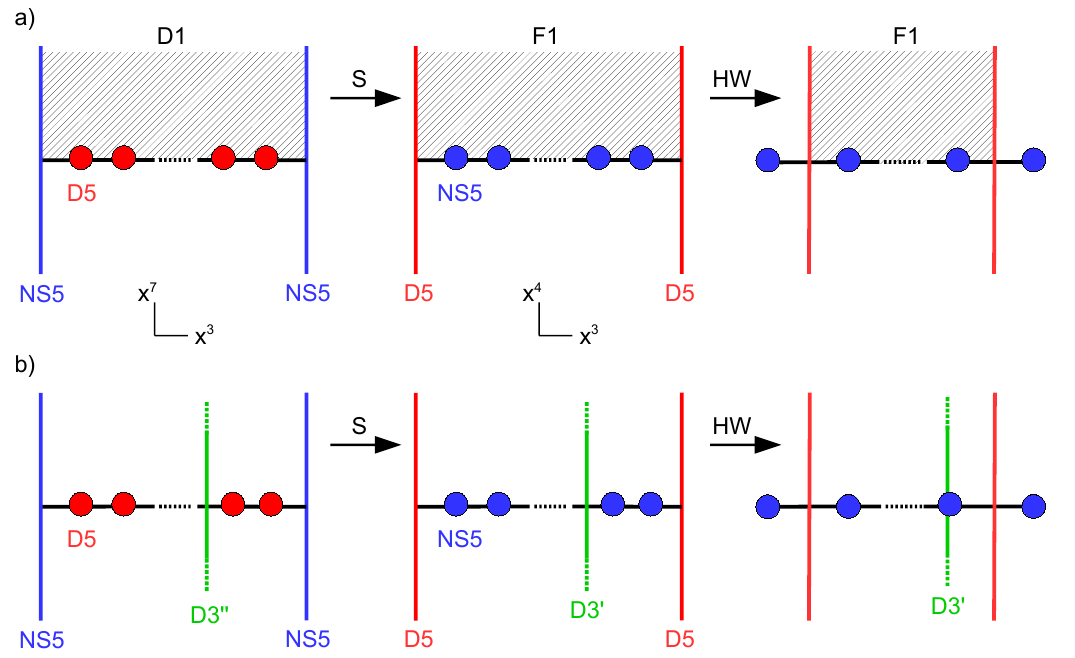
Figure 27 . a) From the brane setup realizing the SQED monopole operator u + to the setup realizing the insertion of the long meson W in T abel . b) From the brane setup realizing the SQED scalar operator ’ to the setup realizing the insertion of the meson Y (= X 0 and HW denote the action of S-duality and Hanany-Witten brane moves respectively.